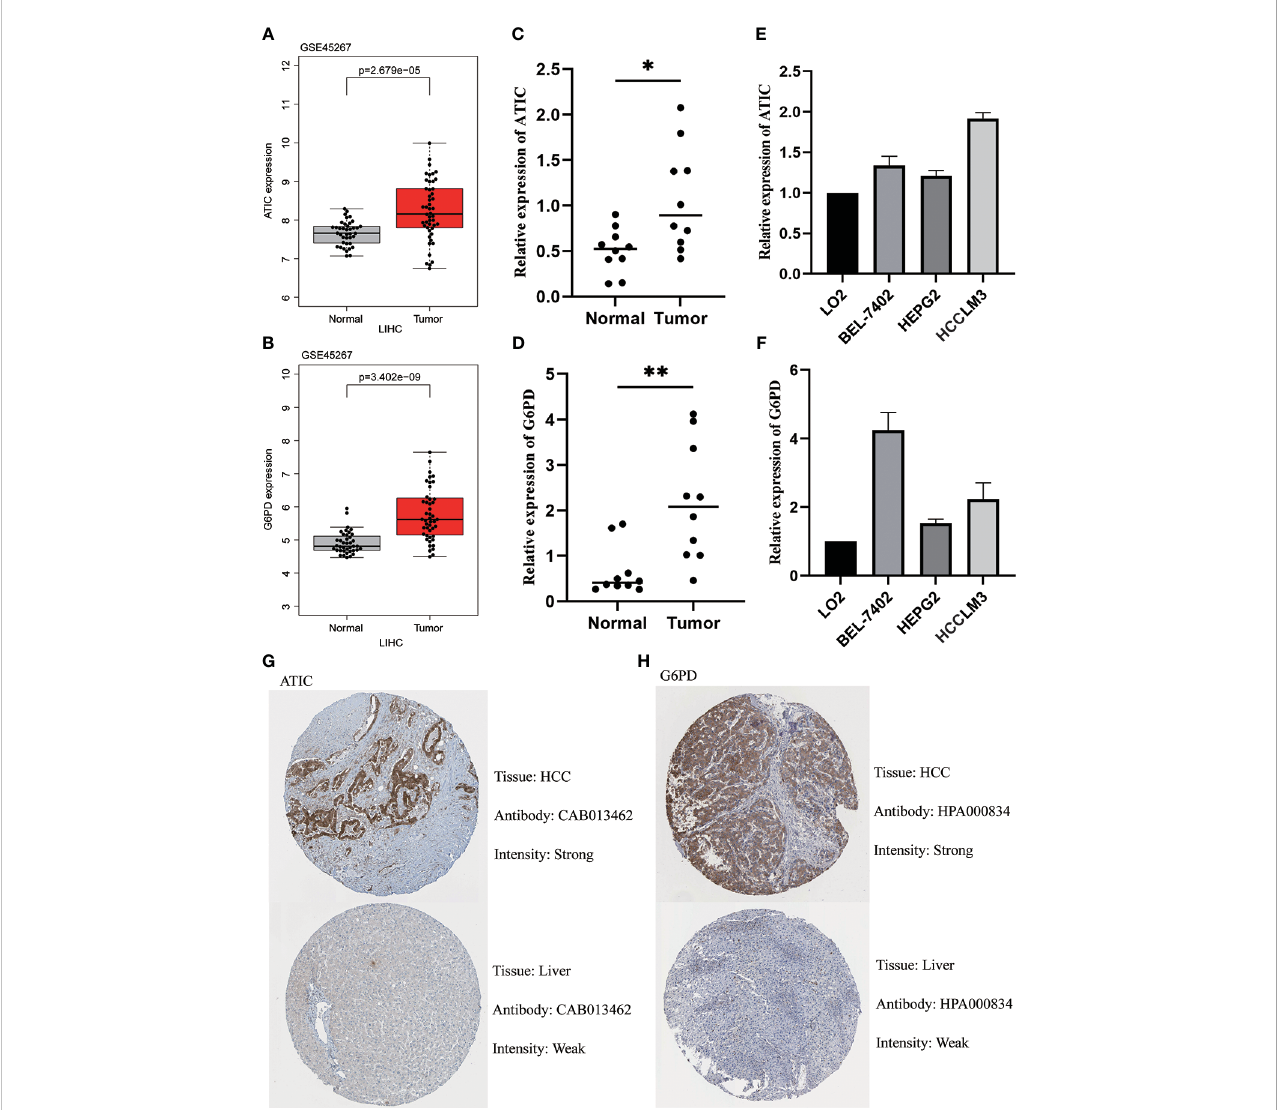
FIGURE 9 Validation of ATIC and G6PD expression in Tissues and Cell Lines. (A, B) GEO database (GSE45267) demonstrates that ATIC and G6PD are signi fi cantly more expressed in tumor tissues than in normal tissues. (C, D) qPCR demonstrates that ATIC and G6PD are signi fi cantly more expressed in tumor tissues than in normal tissues. (E, F) qPCR demonstrated that the expression of ATIC and G6PD was signi fi cantly higher in hepatocellular carcinoma cells than in normal hepatocytes. (G, H) IHC demonstrated that the expression of ATIC and G6PD was signi fi cantly higher in tumor tissues than in normal